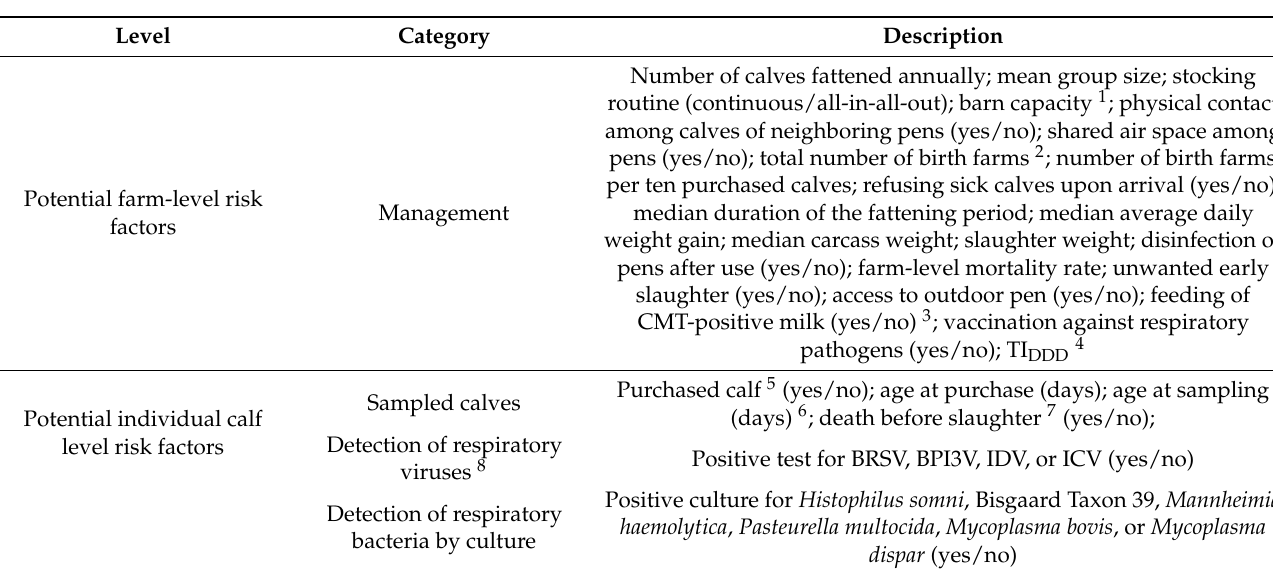
Table 2. Potential risk factors for positive swab sample test for bovine coronavirus (BCoV) in Swiss veal calves from 33